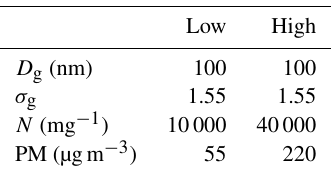
Table 2. Size distribution parameters initialised for simulations ex- amining measured aerosol feedback on meteorology. D g (geometric mean diameter), σ g (geometric standard deviation), N (number con- centration), as well as calculated surface PM concentration for low and high aerosol